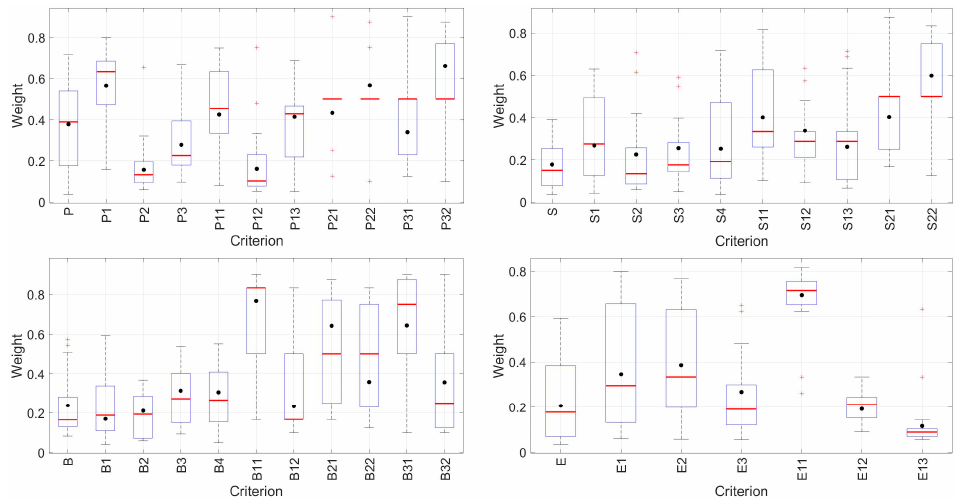
Figure 5. Dispersion of individual expert’s weights for each criterion. The red line indicates the median, and the bottom and top edges of the box indicate the 25th and 75th percentiles, respectively. The whiskers extend to the most extreme data points not considered outliers, and the outliers are plotted individually using the plus red symbol. A black dot marks the final group weight for each criterion.